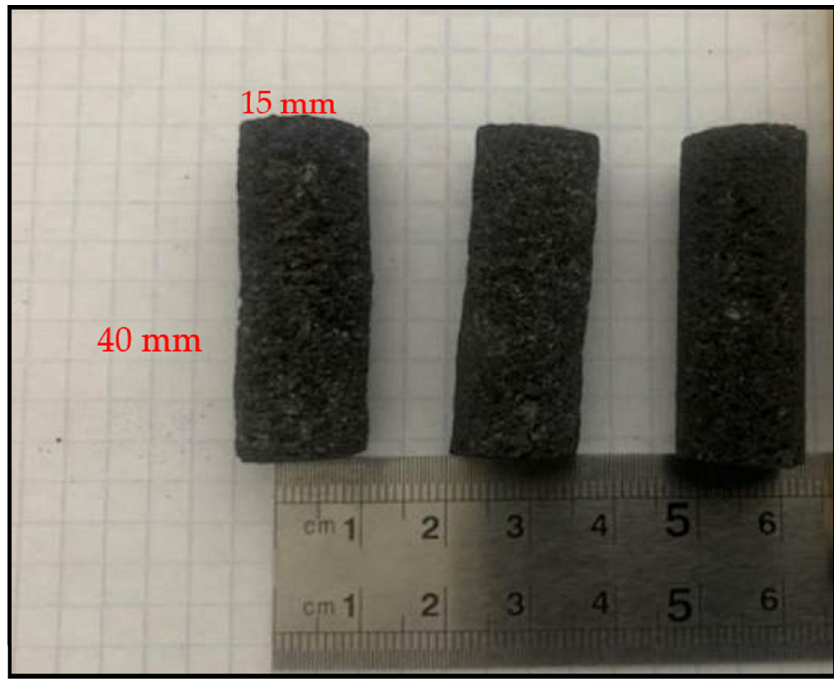
Figure 2. Coke resistivity test samples.